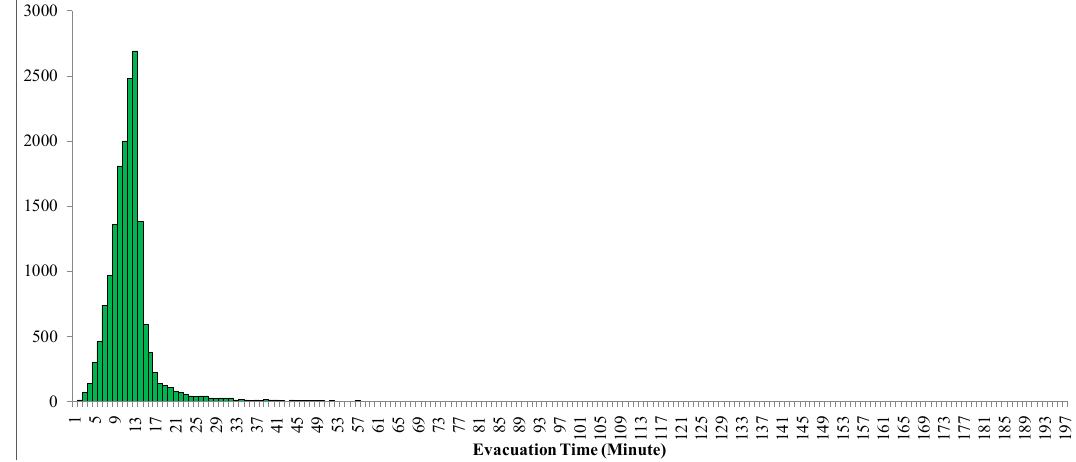
Figure 7. The frequency distribution of evacuation time required for all routes.